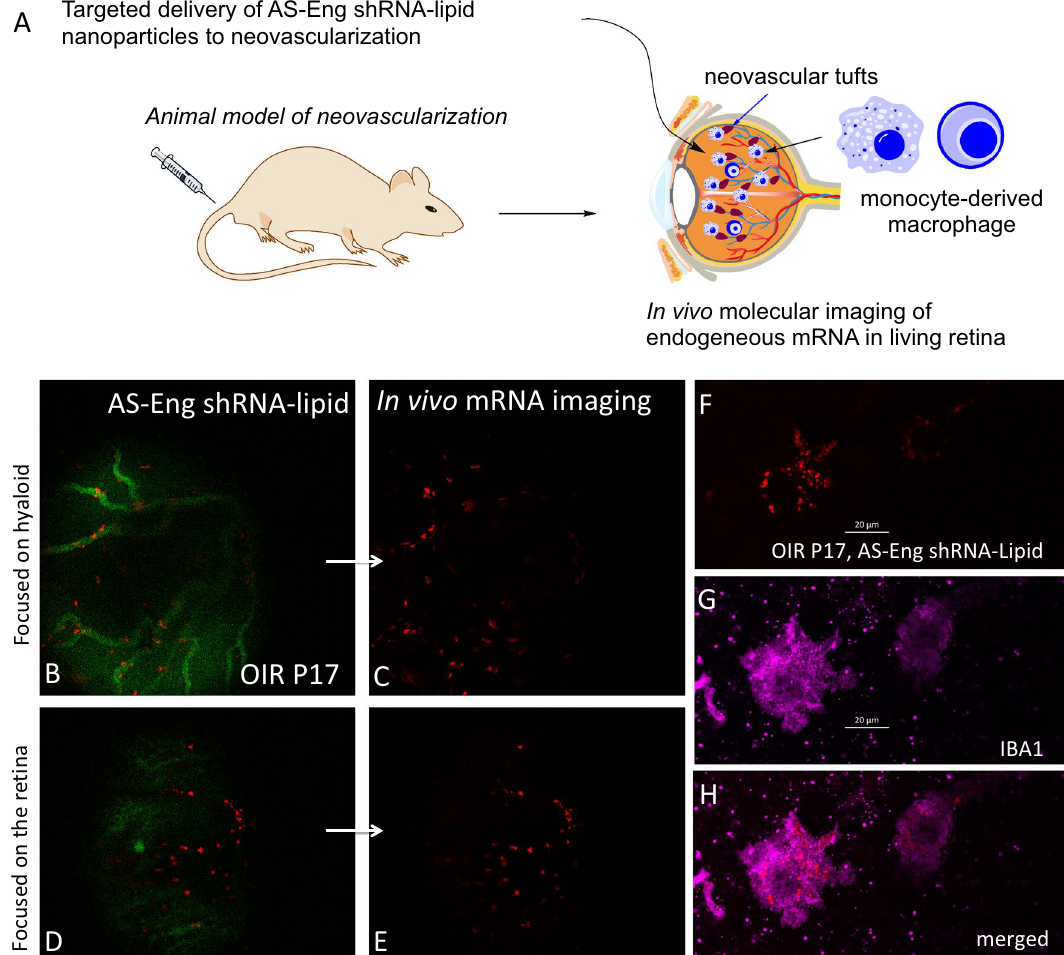
Figure 3. Live imaging of endogenous mRNA in the OIR retina from a P17 OIR mouse receiving an intraperitoneal injection of AS-Eng shRNA–lipid (probe). Schematic drawing representing in vivo probe delivery to neovascular tufts ( A ). Fluorescein angiography was performed to visualize the hyaloid ( B ) and the superficial ( C ) vasculatures. An intense endoglin mRNA-dependent red punctate fluorescence resulting from internalization of the AS-End shRNA–lipid by cells associated with the hyaloid vasculature ( B , C ) and pre-retinal neovascular tufts ( D , E ). Ex vivo imaging of flatmounted retinas previously imaged in vivo ( F – H ). IBA1 is a microglia/macrophage marker. An intense endoglin mRNA-dependent red punctate fluorescence localized to IBA-1 positive microglial cells as observed in in vivo images ( F – H ). Retinal flatmounts were immunostained with antibodies against